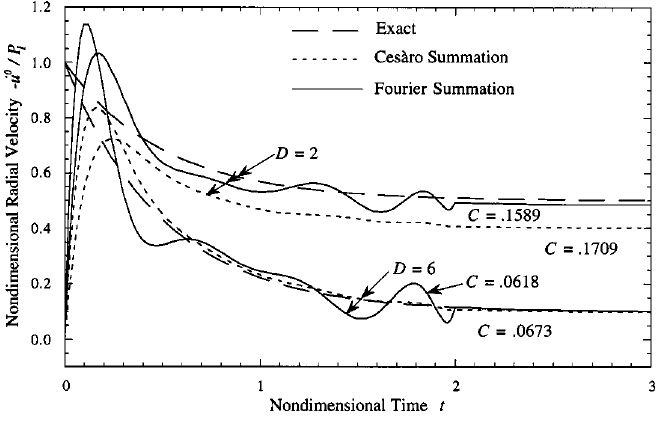
Fig. 14. Incident-wave radial-velocity histories at r = 1, (cid:18) = (cid:25) for several incident spherical waves with (cid:12) = 2; N = 7.